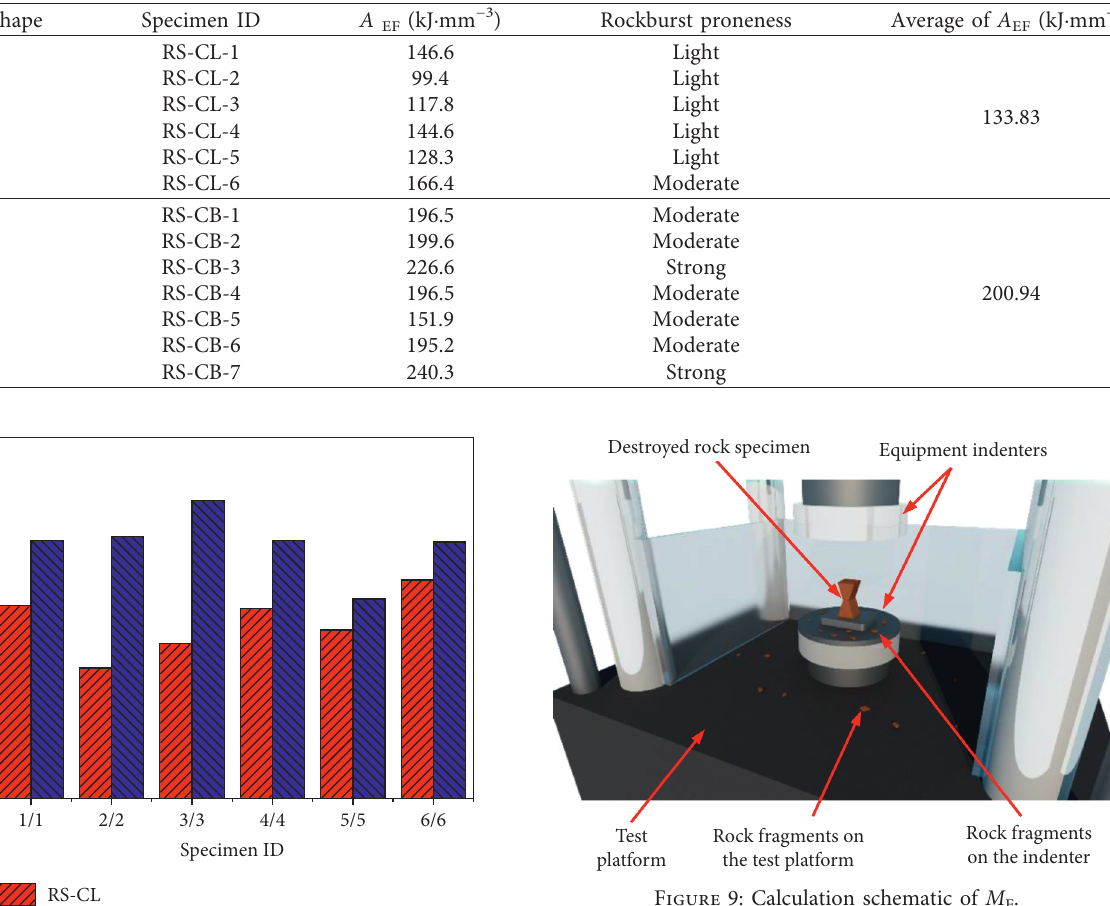
Table 7: Calculations of the residual elastic energy index of specimens.